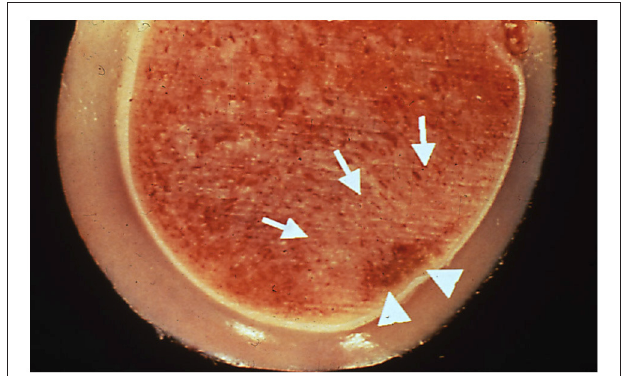
FIGURE 2 | Postmortem sample of a distal metacarpus from the leg opposite to that suffering a catastrophic injury in a racehorse. Although there is intact articular cartilage, subchondral bone necrosis (arrowheads) and sclerosis (arrows) can be seen. Reprinted from McIlwraith et al. (3), with permission from